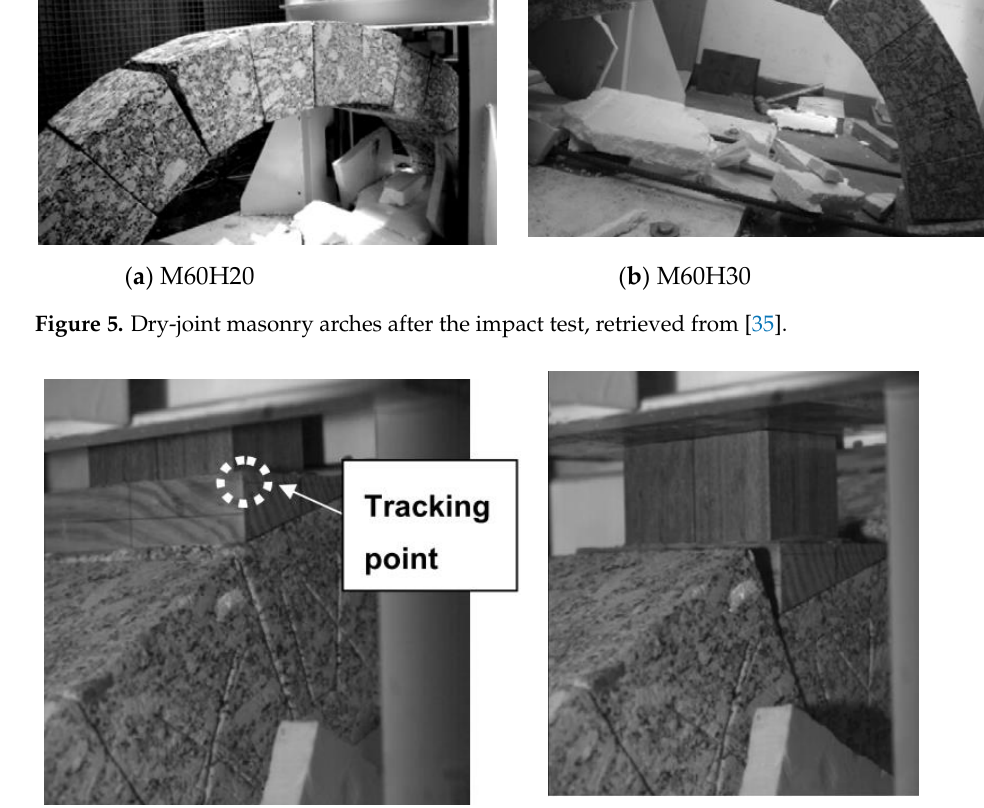
Table 3. Maximum vertical responses obtained at quarter span during the experiments.